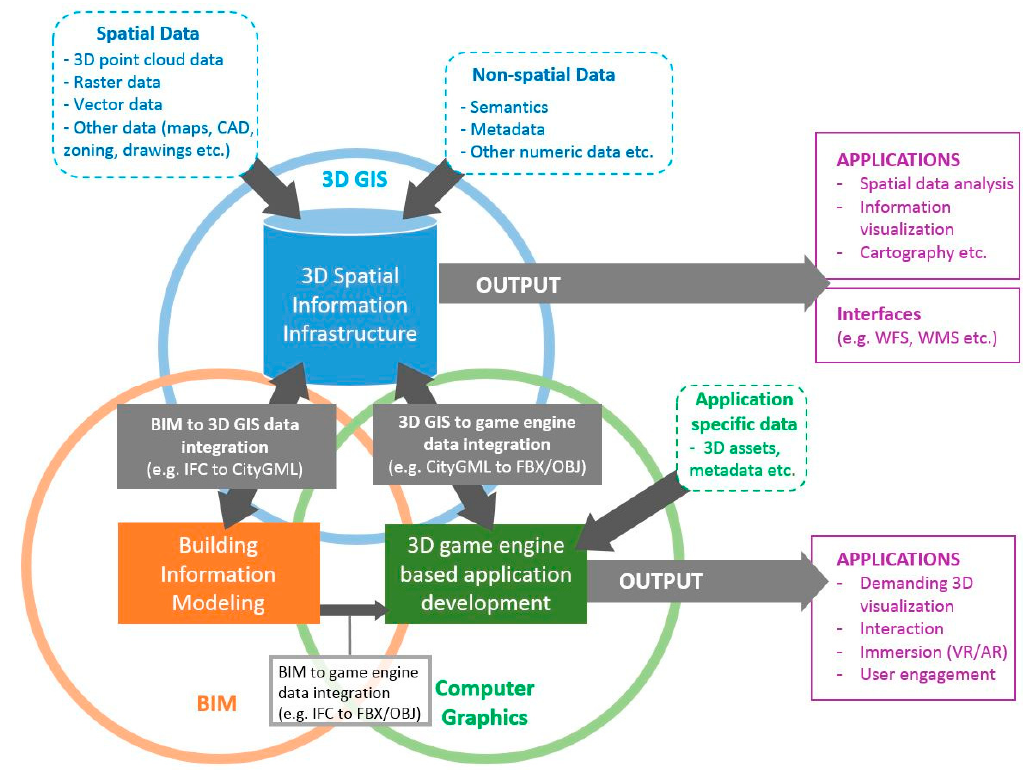
Figure 6. The concept for harmonizing 3D city modeling.